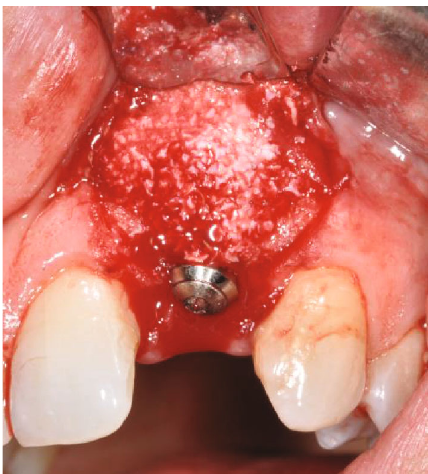
Figure 6: Clinical conditions after 2 years.